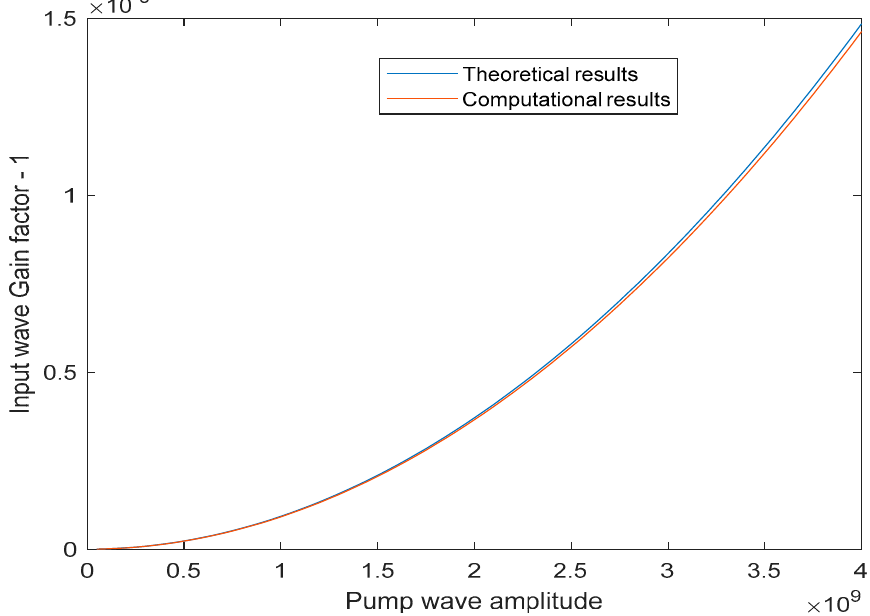
Figure 11. Comparison of the parametric amplification rates with respect to the pump wave amplitude.